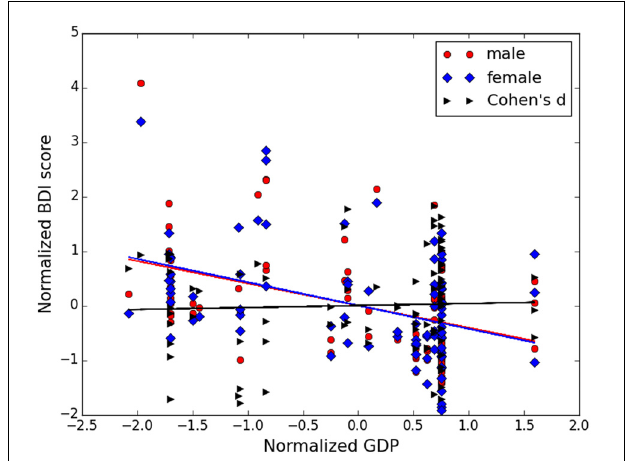
FIGURE 3 | Scatter plots between GDP (gross domestic product) per capita and male BDI (Beck Depression Inventory) score (red), between GDP per capita and female BDI score (blue), and between GDP per capita and Cohen’s d (black). All data were normalized for illustration